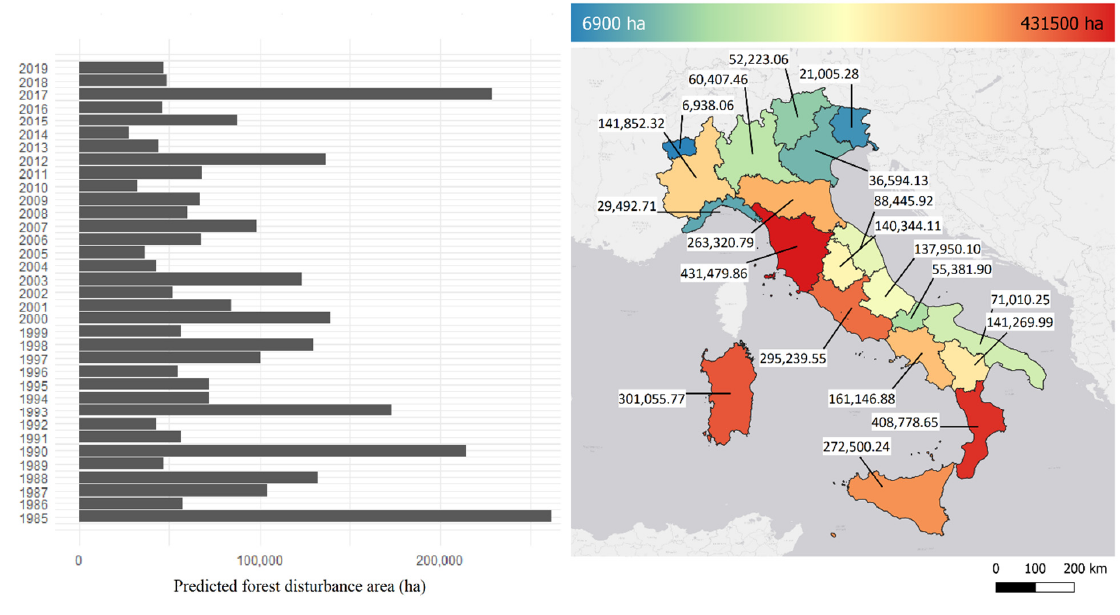
Figure 5. Per year area of forest disturbance predicted in Italy. On the right, the overall disturbance area is shown per